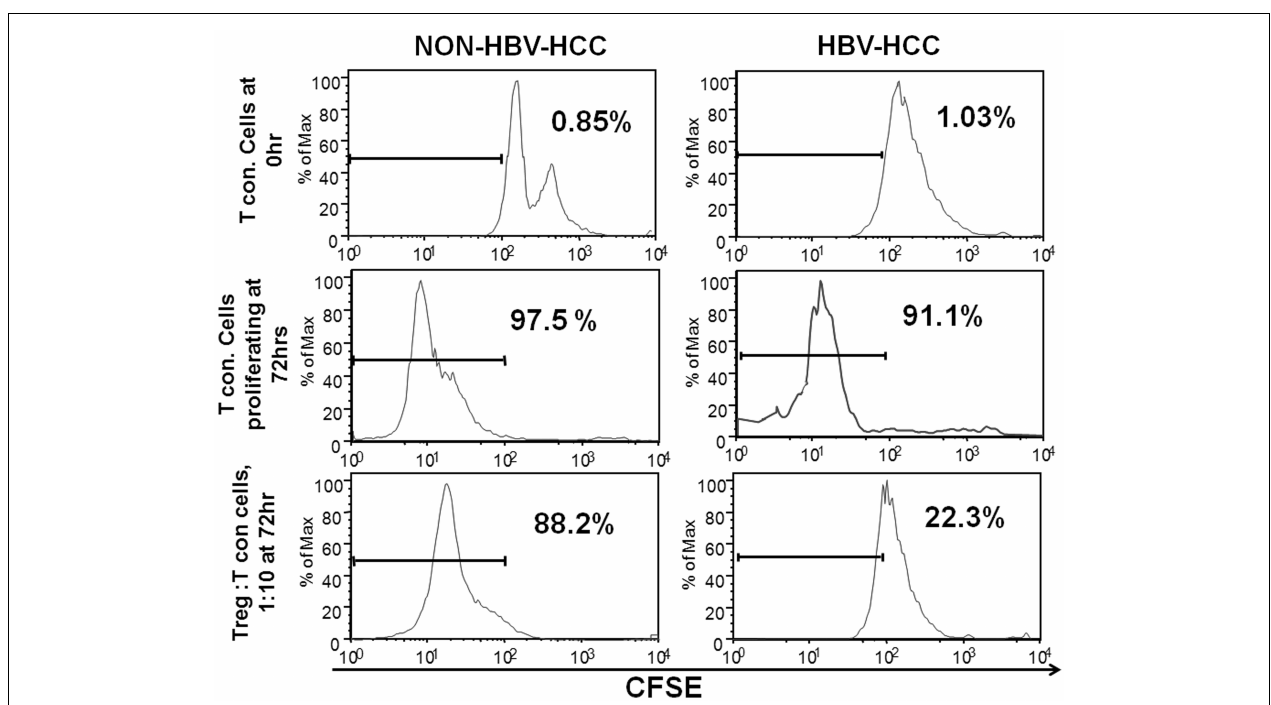
FIGURE 2 | (A) CD4 + CD25 + CD127 low Tregs were analyzed using CD25 and CD127 markers on CD4 + gated population ofT cells. Representative flow-cytometric dot plots and scatter plot showing the frequencies of